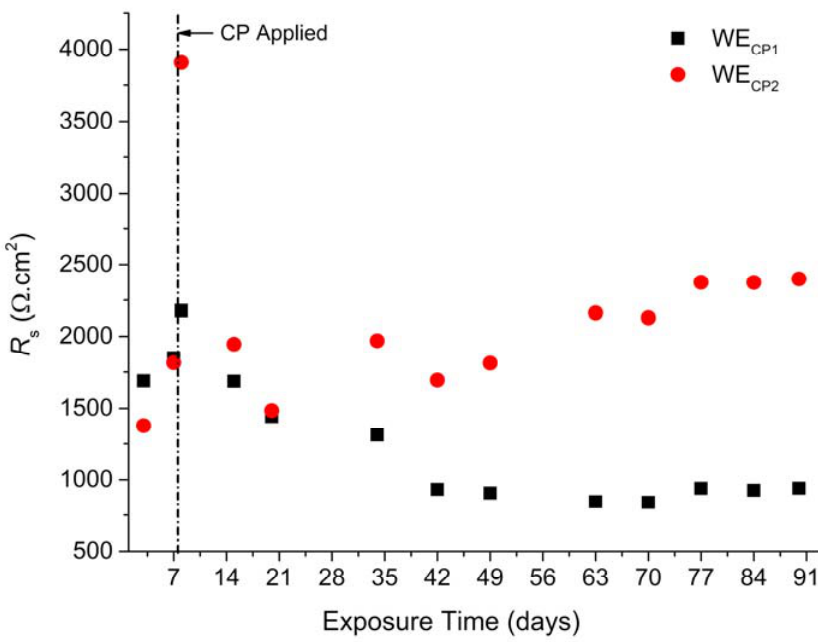
Figure 2. R s evolution with exposure time for coupons WE CP1 and WE CP2 .